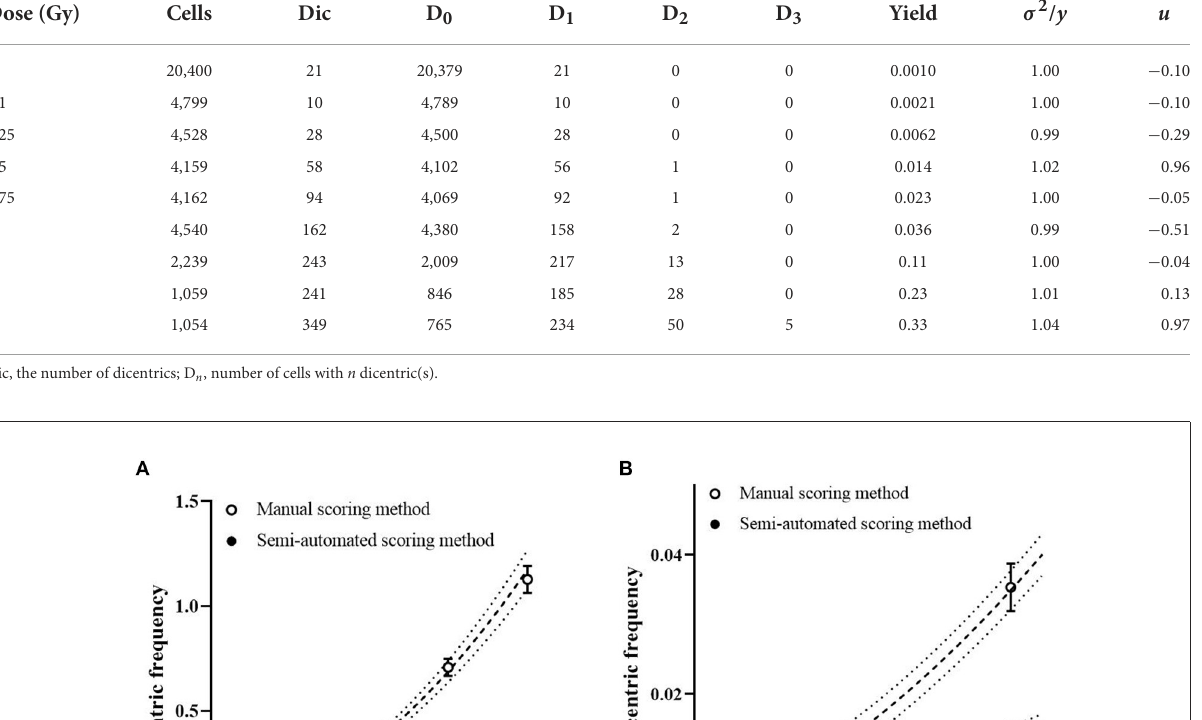
which indicates that there was a substantial agreement between the results of the two methods without systematic